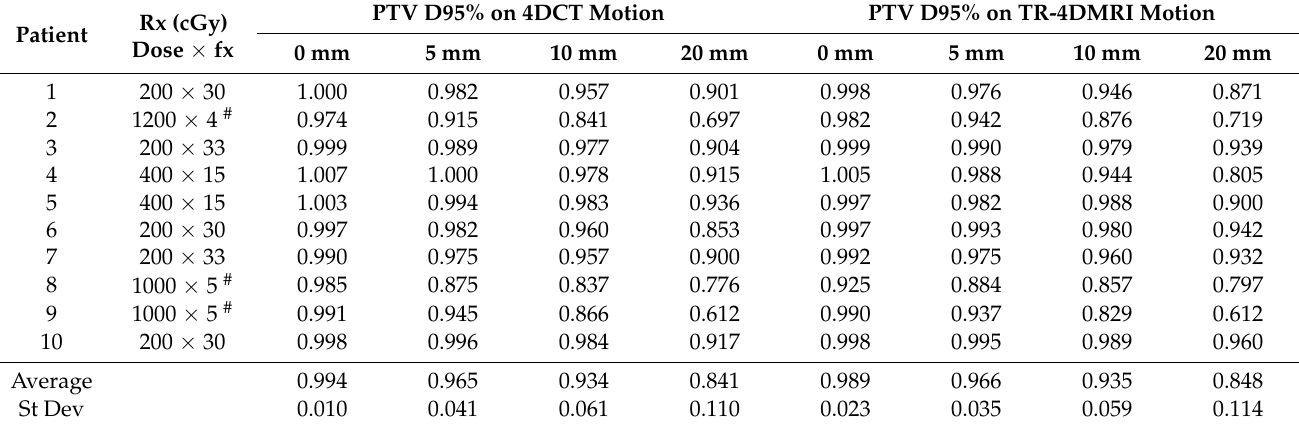
# Lung location abbreviation: RLL — right lower lobe, LUL — left upper lobe, RML — right middle lobe, RUL — right upper lobe.